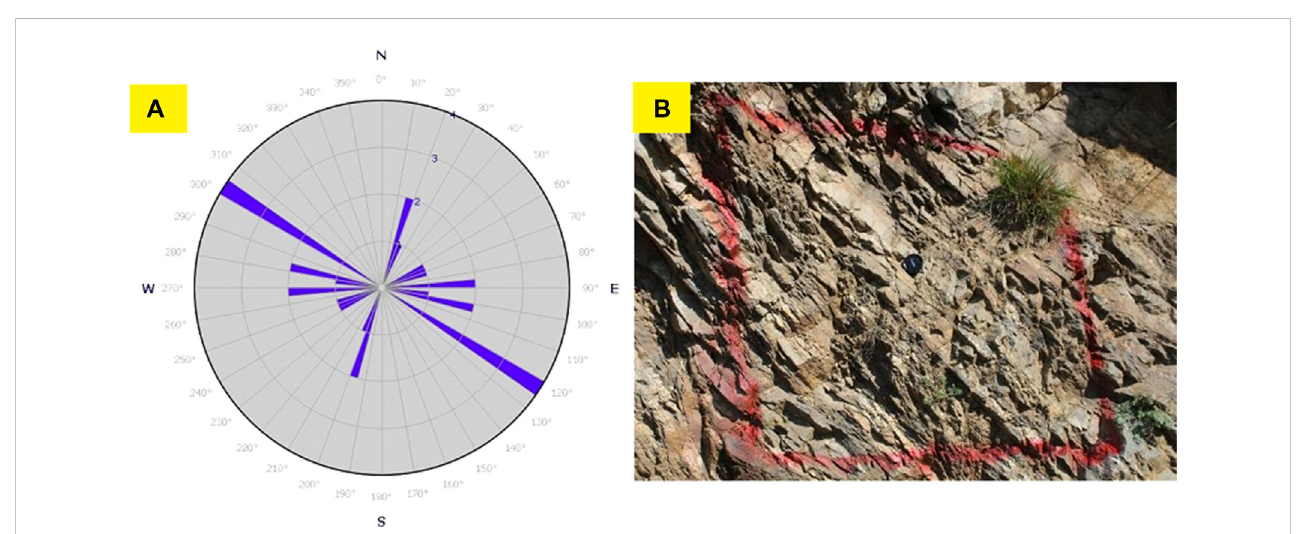
FIGURE 3 (A) Rose diagram showing the orientation of highly fractured rocks and (B) high joint density